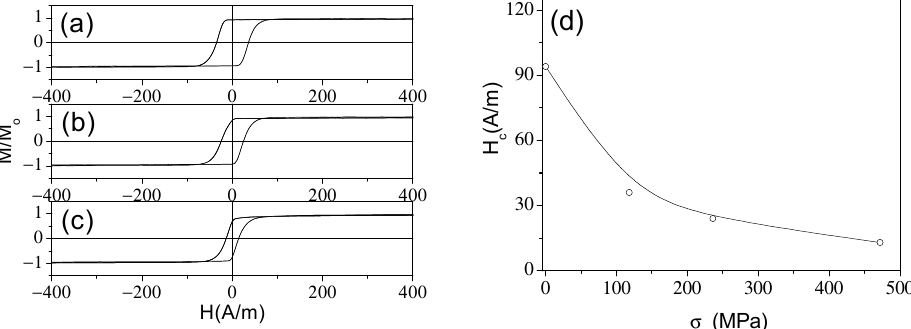
Figure 19. Hysteresis loops of Fe 3.6 Co 69.2 Ni 1 B 12.5 Si 11 Mo 1.5 C 1.2 microwires stress-annealed at different conditions: T ann = 200 ◦ C ( a ), T ann = 350 ◦ C ( b ) and T ann = 375 ◦ C ( c ). (Reproduced with permission from [49] Figure 7 Copyright © 2020 Elsevier B.V.)